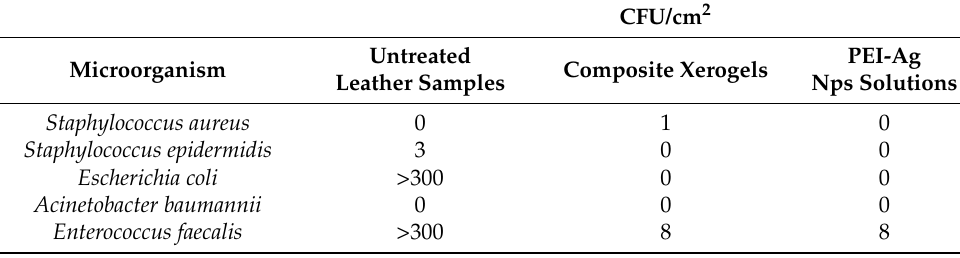
Table 5. Sonicated leather sample colony